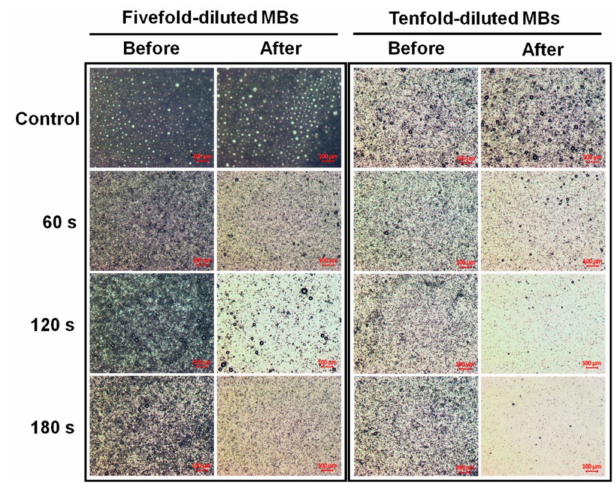
Figure 3. Microscopy images of five- and tenfold-diluted MBs without and with Nd:YAG pulsed-laser irradiation at 60, 120, and 180